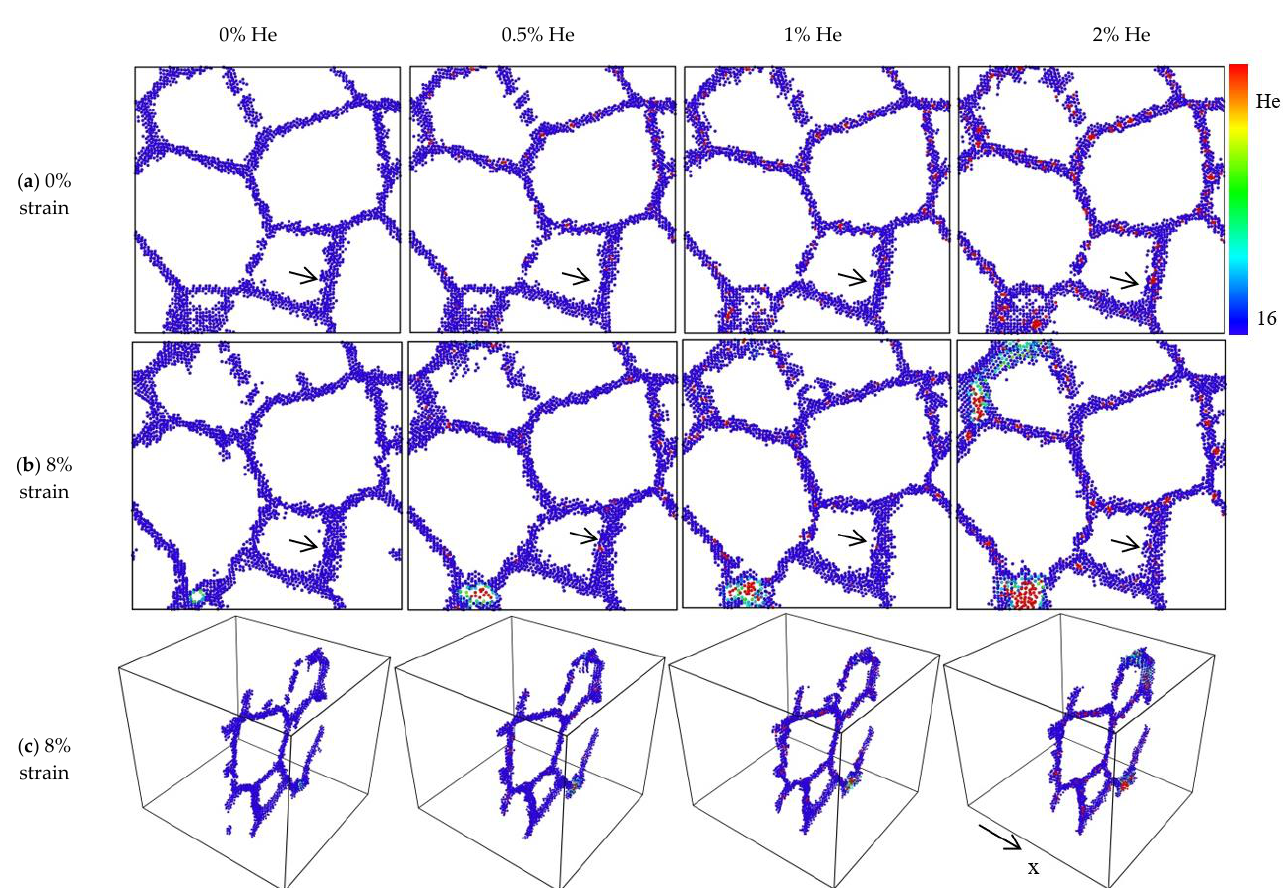
Figure 5. The cross sections of nanocrystalline BCC Fe: ( a ) before loading; ( b ) deformed to 8% strain; and ( c ) deformed to 8% strain. The loading direction is parallel to x-axis. The Fe atom in BCC region is filtered out for clarity. The red represents He atom and the Fe atoms are colored according to atomic volume, see the color bar.